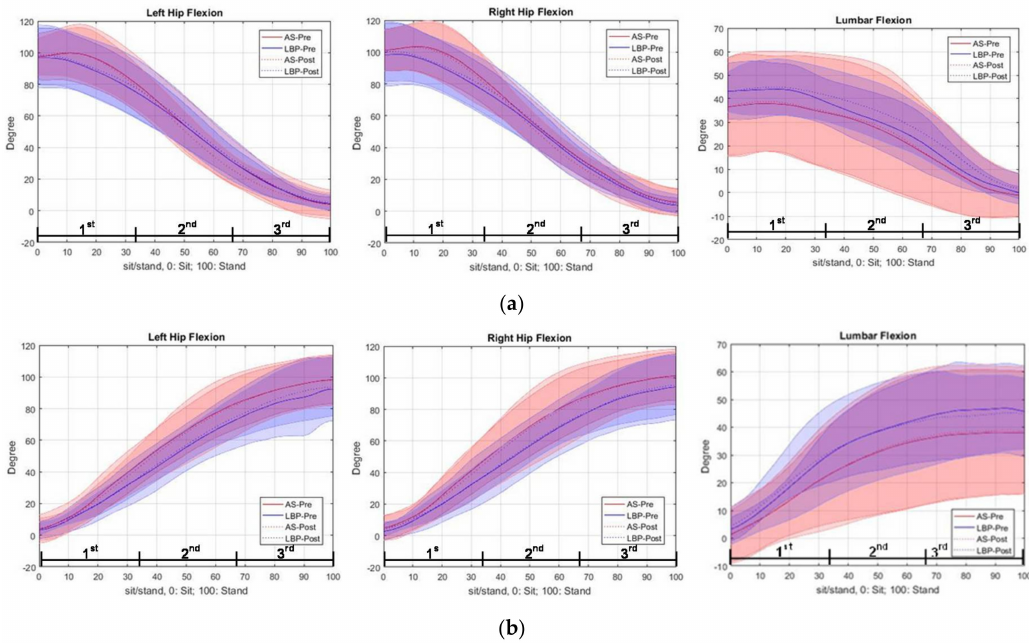
Figure 4. Trajectories of lumbar spine and hip joint angles (mean ± 1SD) during ( a ) squat-to-stand phase and ( b ) stand-to-squat phase, before and immediately after squatting. The mean values of the pre-squatting performance (solid lines) and post-squatting performance (dotted lines) are presented with the red lines for the AS group and the blue lines for the LBP